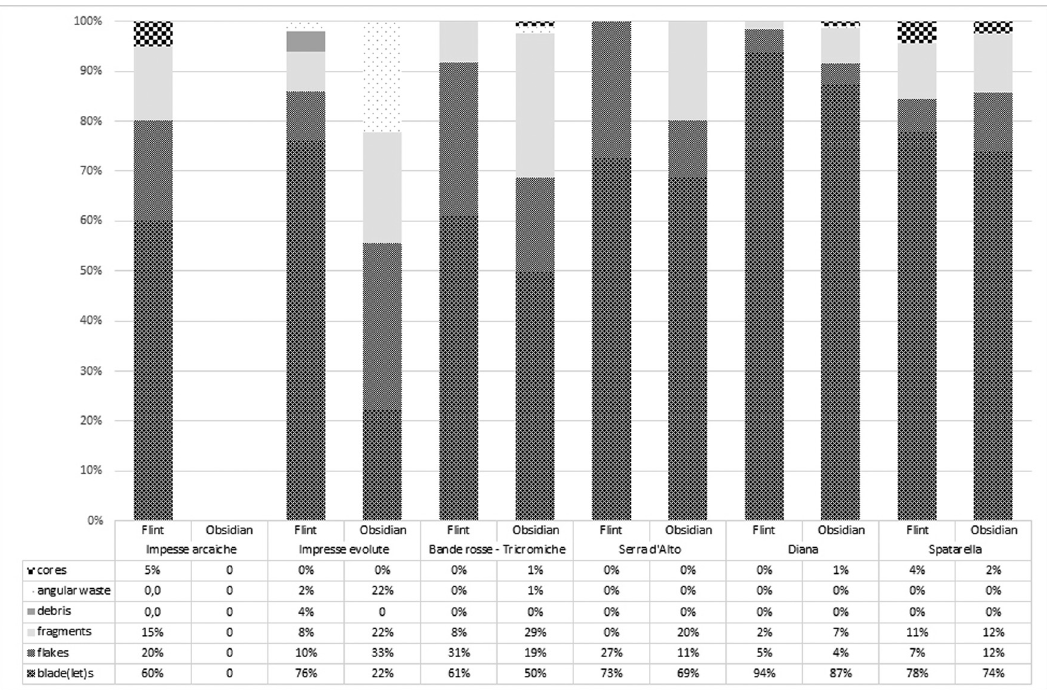
Figure 3: Basic typological counts of obsidian artifacts: the category “ blade ( let ) s ” includes the laminar supports at all ( whole supports; proximal, mesial, and distal portions )